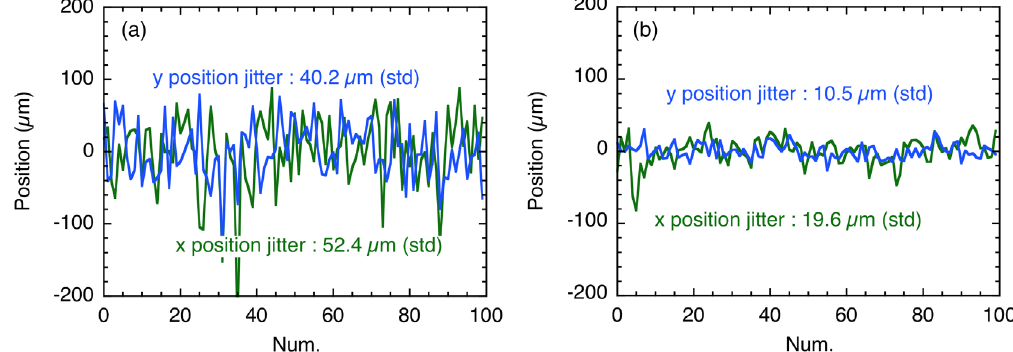
16. Laser pointing stability observed 80 m downstream of the undulator exit (a) before and (b) after the heater replacement. The laser position was measured using the beam-line screen